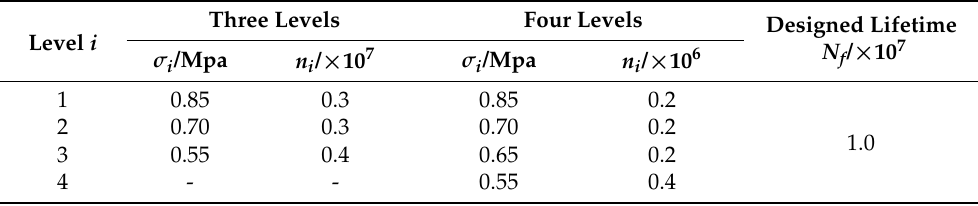
Table 1. Load spectrum of steel bridge deck asphalt pavement